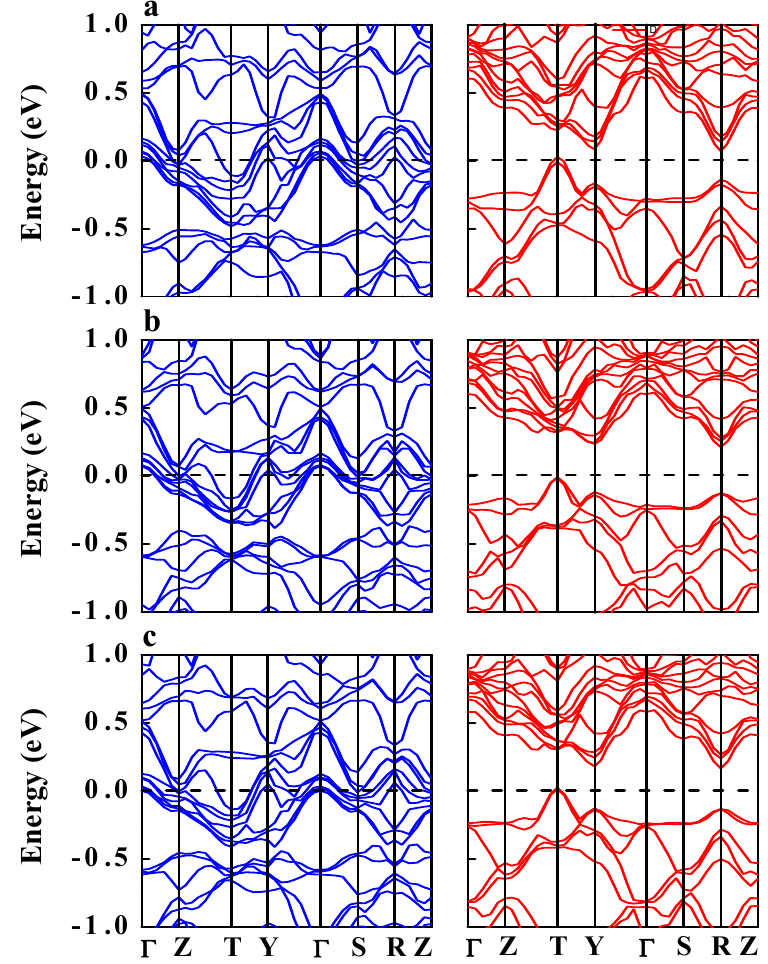
Figure 5. Spin-resolved electronic band structures of ( a ) Ti 2.25 Co 0.75 Si 0.5 B 0.5 , ( b ) Ti 2.25 Co 0.75 Si 0.5 Al 0.5 , and ( c ) Ti 2.25 Co 0.75 Si 0.5 Ga 0.5 at the equilibrium lattice parameters. The zero of the energy scale is set at the Fermi energy. The blue and red solid lines represent the spin-up and spin-down states, respectively.